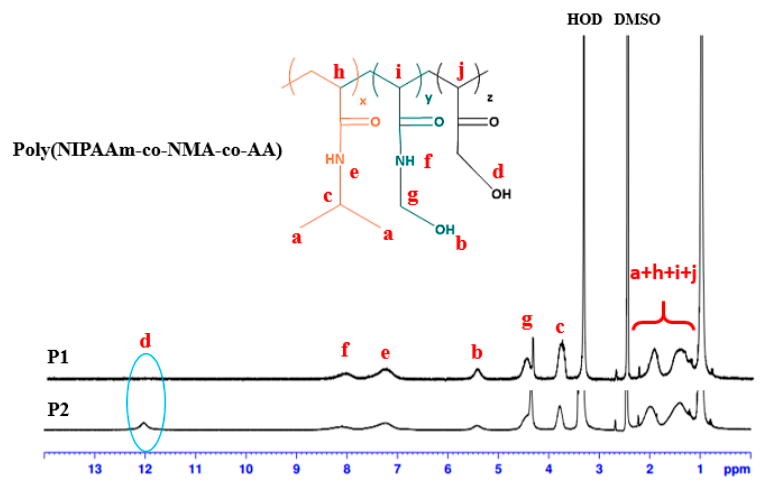
Figure 4. 1 H-NMR spectrum of poly(NIPAAm- co -NMA- co -AA) in DMSO.